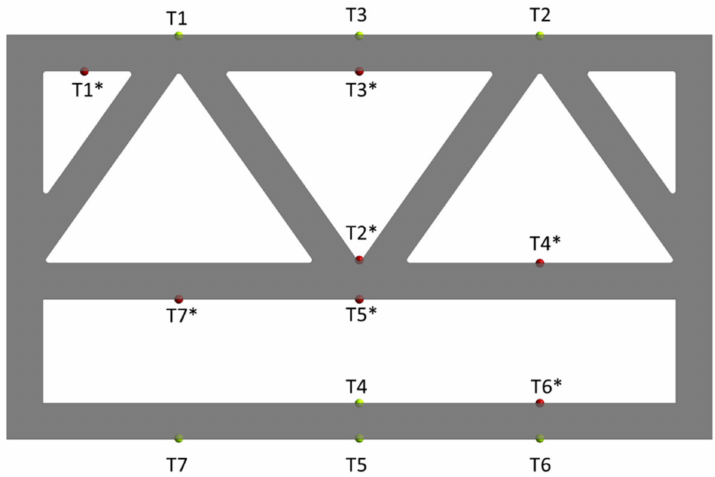
Figure 13. Numerical temperature sensors’ positions (T 1 -T 7 are temperature measurement sensors, T 1* -T 7* are additional sensors for temperature measurement).